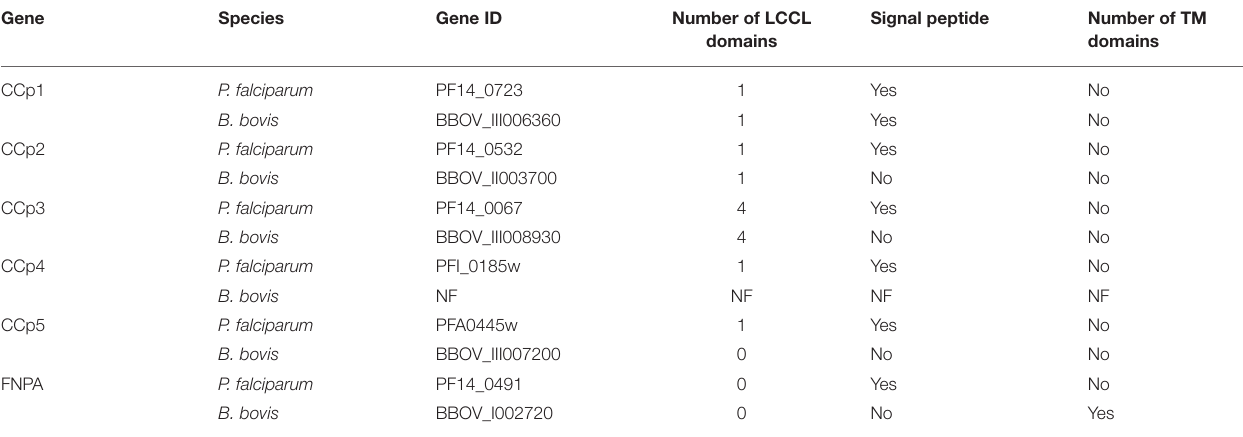
TABLE 1 | Comparison of CCp proteins among P. falciparum and B. bovis parasites. Gene Species Gene ID Number of LCCL